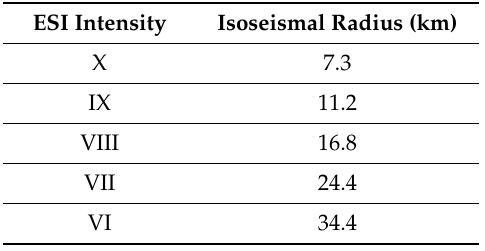
Table 2. Isoseismal radii obtained from the IPE (Intenstiy Prediction Equation, Equation (1)), considering an ESI epicentral intensity of